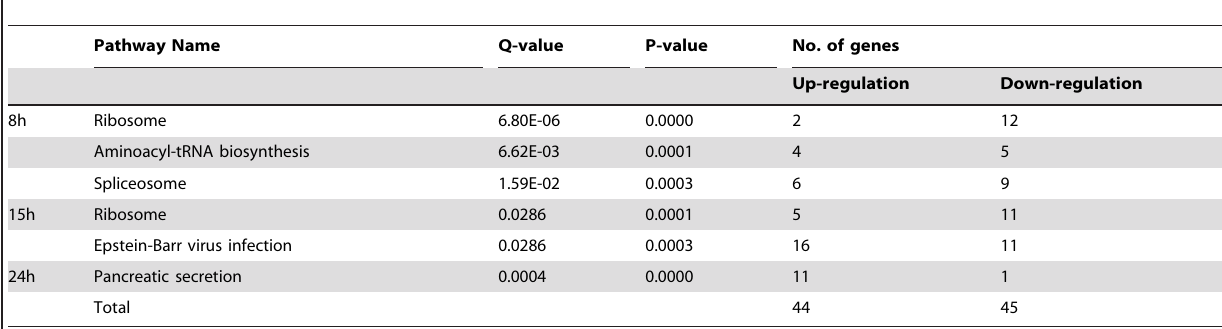
Table 3. DEGs involved in the significantly enriched KEGG Pathways at 8, 15 and 24